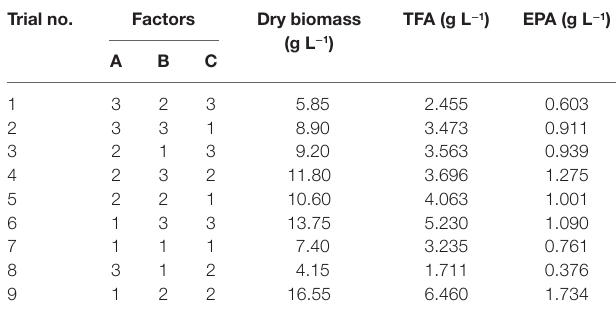
TaBle 4 | Results of OA 9 matrix orthogonal test. Trial